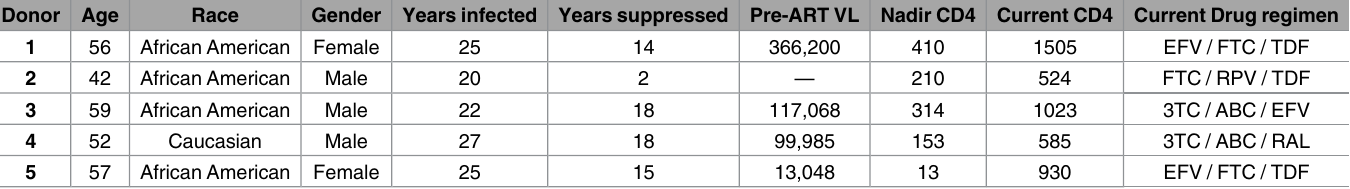
Table 1. Characteristics of study subjects.